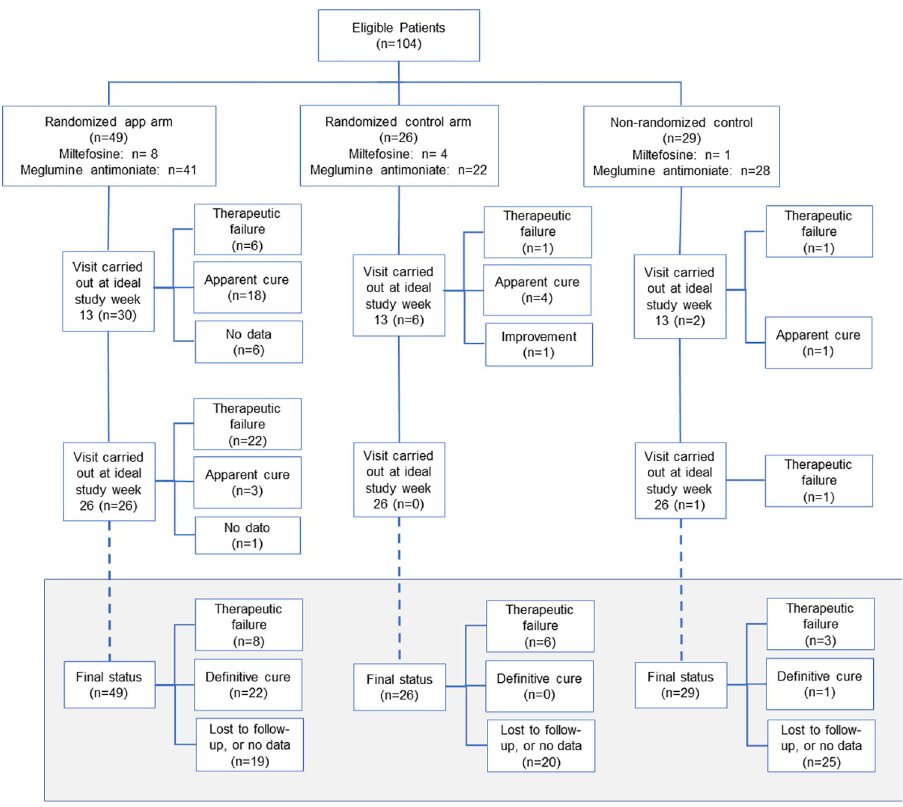
Fig 3. CONSORT flowchart. The lower part, in grey, is a summary of the outcomes, based on all the timepoints.